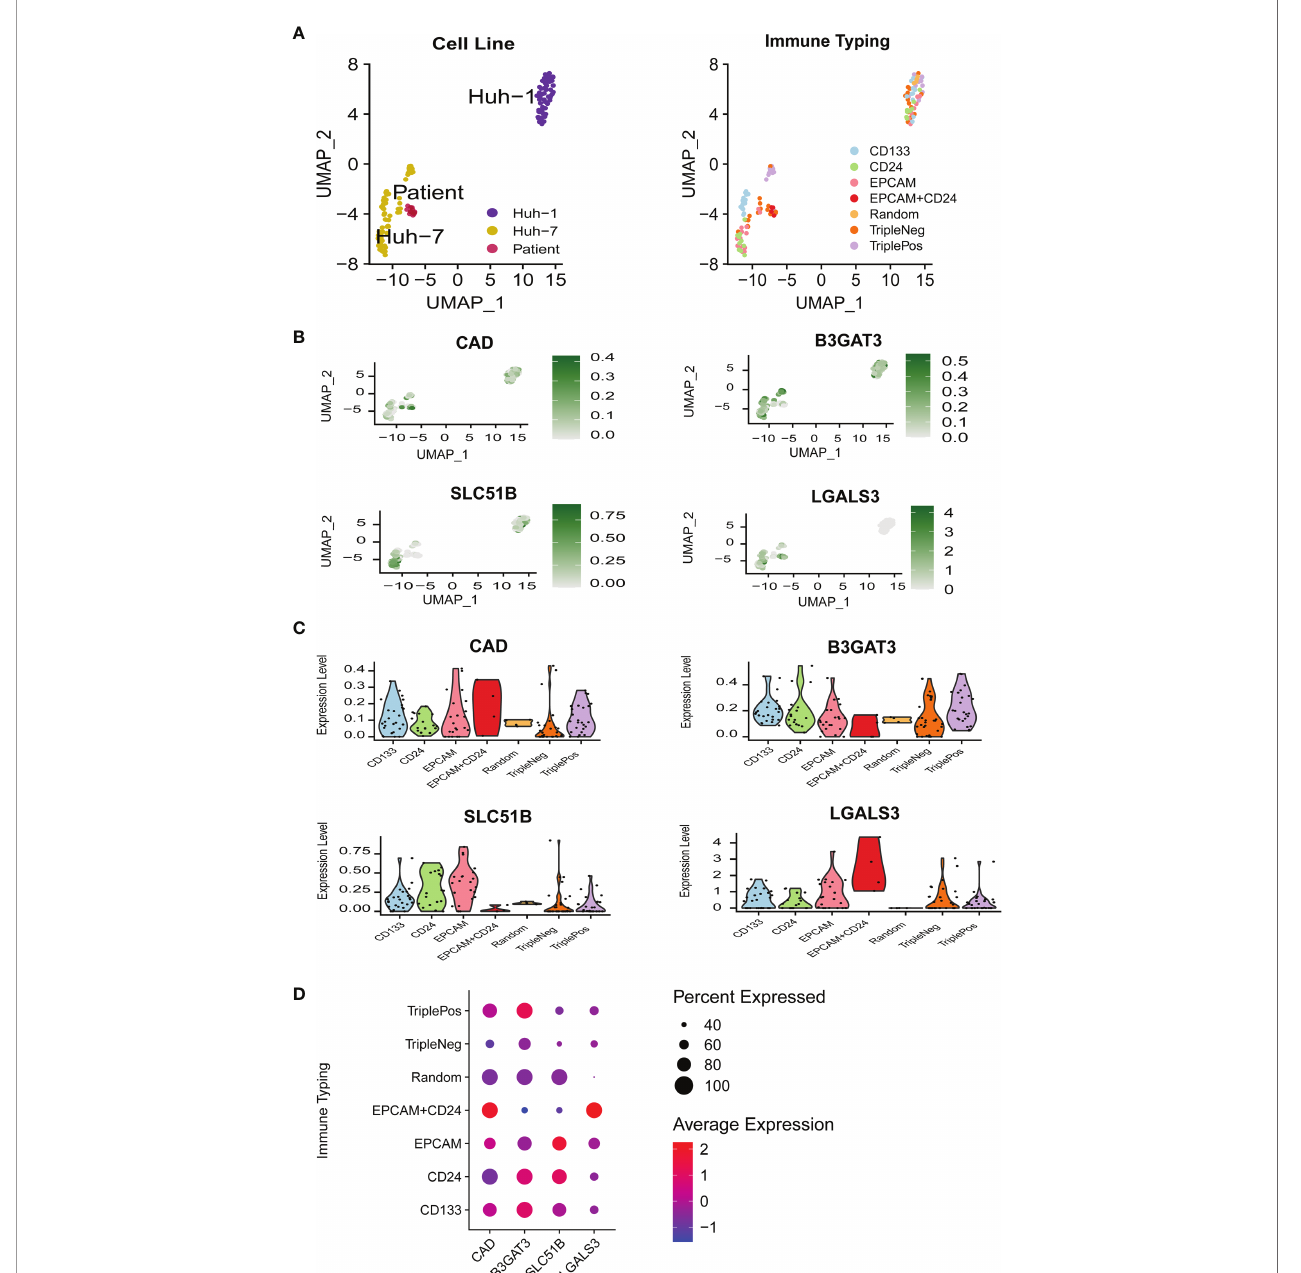
FIGURE 4 | The relationship between gene expression pro fi les and HCC stemness in single-cell RNA-sequencing data. (A) UMAP plots of 130 single cells using different classi fi cations. (B) UMAP plots of the four glycosylation-related genes in CSC (MT3 was not detected in GSE 103866). (C) Violin plots of the four glycosylation-related gene expressions in CSC. (D) Expression of the four glycosylation-related genes in different immune phenotypes. CSC, cancer stem